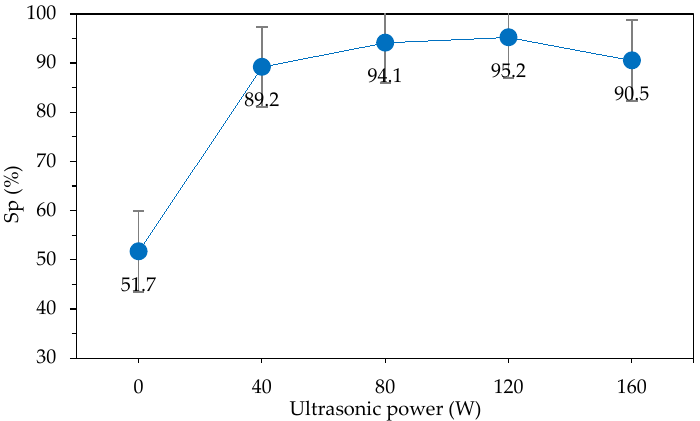
Figure 8. Effect of ultrasonic power on saponin content.